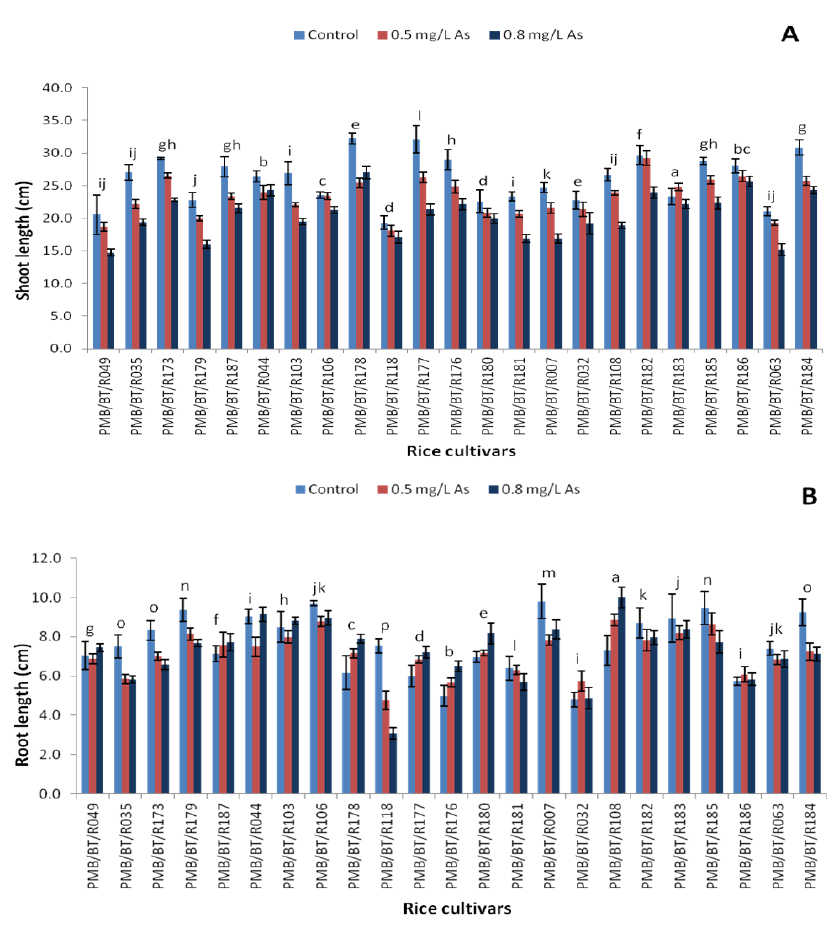
Figure 1 Shoot lengths ( A ) and root lengths ( B ) (in cm) under arsenic stress. Data are presented as the mean ± SE ; n = 3. Columns topped by the same letter(s) indicate that the percentage changes in the parameter values of the represented cultivars at the 0.8 mg/L arsenic concentration do not differ significantly at the 5% level according to Duncan’s multiple-range